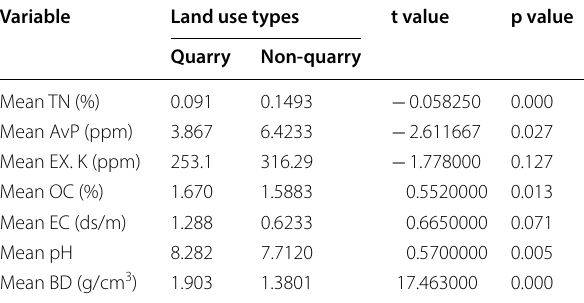
Table 5 Soil chemical and physical pparameters on Quarry and Non-quarry